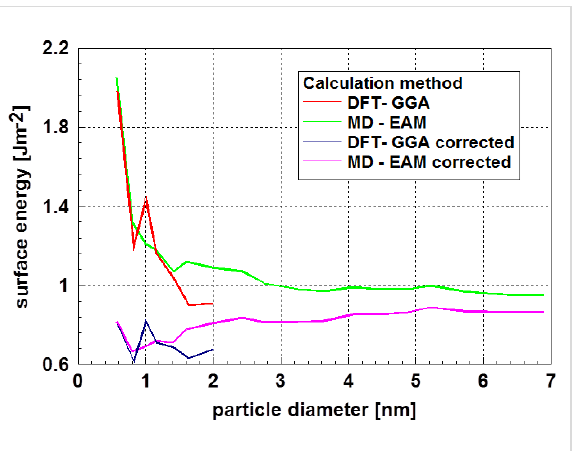
Figure 17: Surface energy of aluminum particles as function of the particle diameter [58]. This graph shows both the original values and those corrected according to Holec et al. [53]. With the exception of the systematic variation of the values for particle diameters below 2 nm, the corrected values show a trend of decreasing surface energy with decreasing particle size for particle diameters larger than 2 nm.